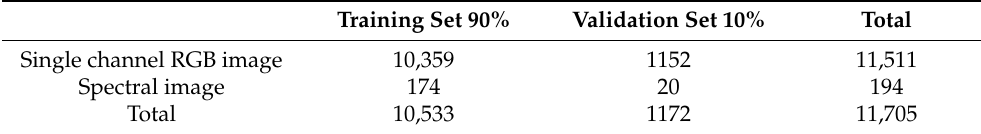
Table 3. ResNet34 pre-training data analysis.